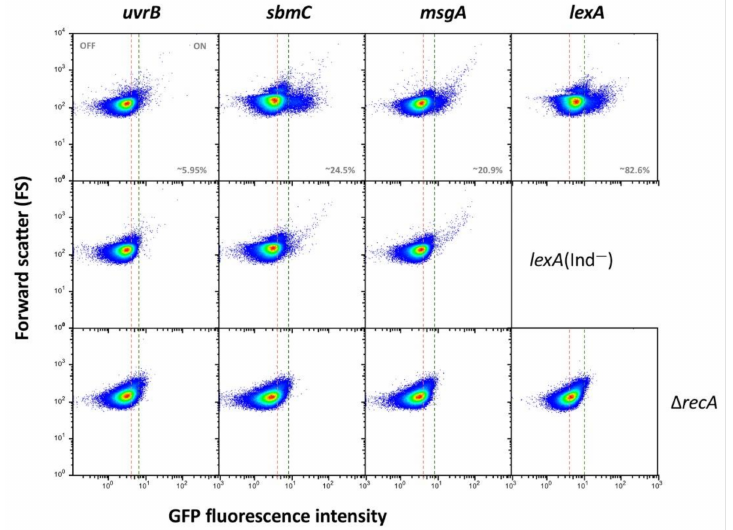
Figure 3. Formation of LexA dependent and LexA-independent ON subpopulations in genes of group III. The pink dashed line shows the boundary between OFF and ON states, established as the expression level of a non-fluorescent sample (Supplementary Figure